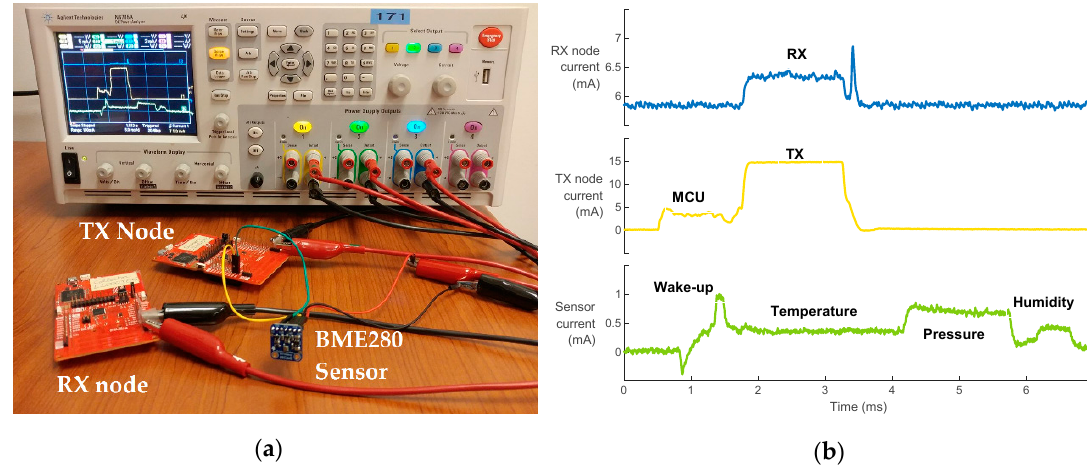
Figure 5. ( a ) Test setup for transceiver and sensor current measurement, and ( b ) current consumption breakdown of the sensor, transmitter, and receiver during one measurement.